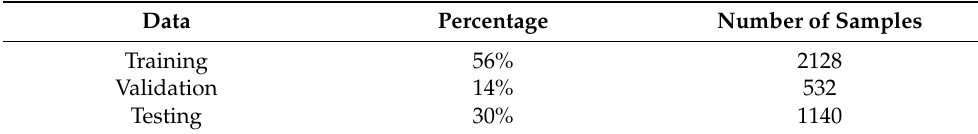
Table 2. Dataset samples.